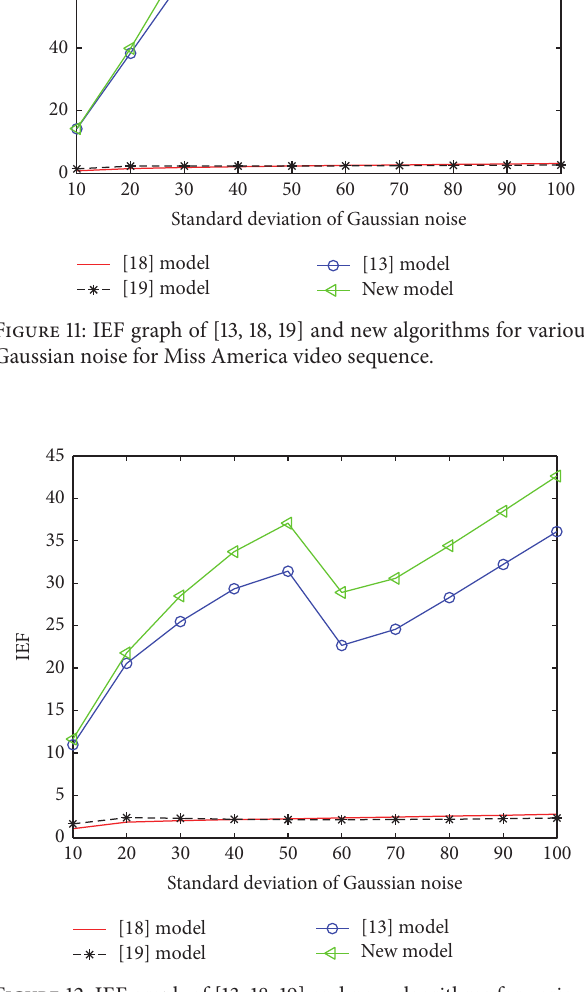
Figure 12: IEF graph of [13, 18, 19] and new algorithms for various Gaussian noise for Salesman video